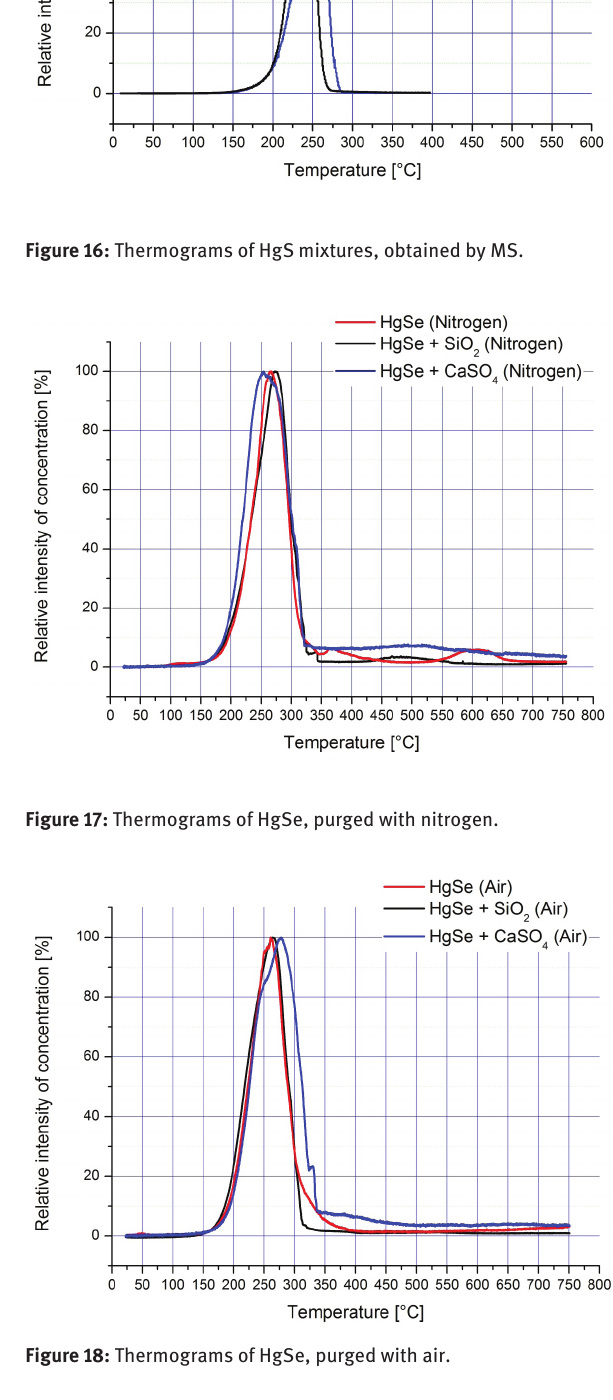
Figure 18: Thermograms of HgSe, purged with